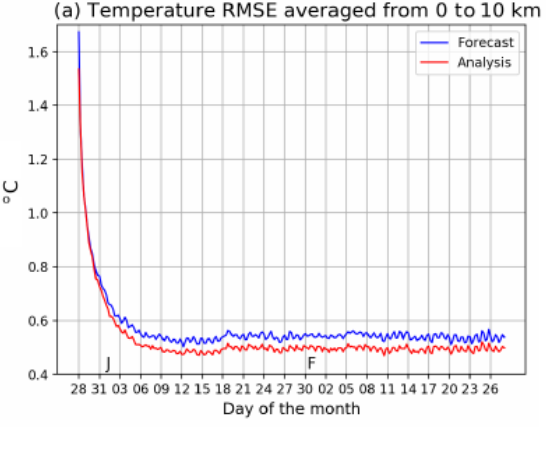
from the observation’s location. This function is used as